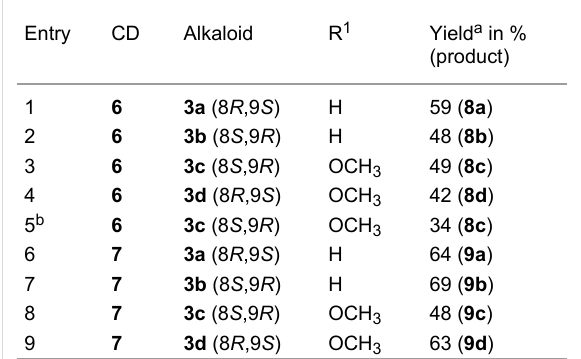
Table 2: Yields for optimized conditions of CuAAC click reaction of permethylated azido-CDs with propargylated cinchona alkaloids from Scheme